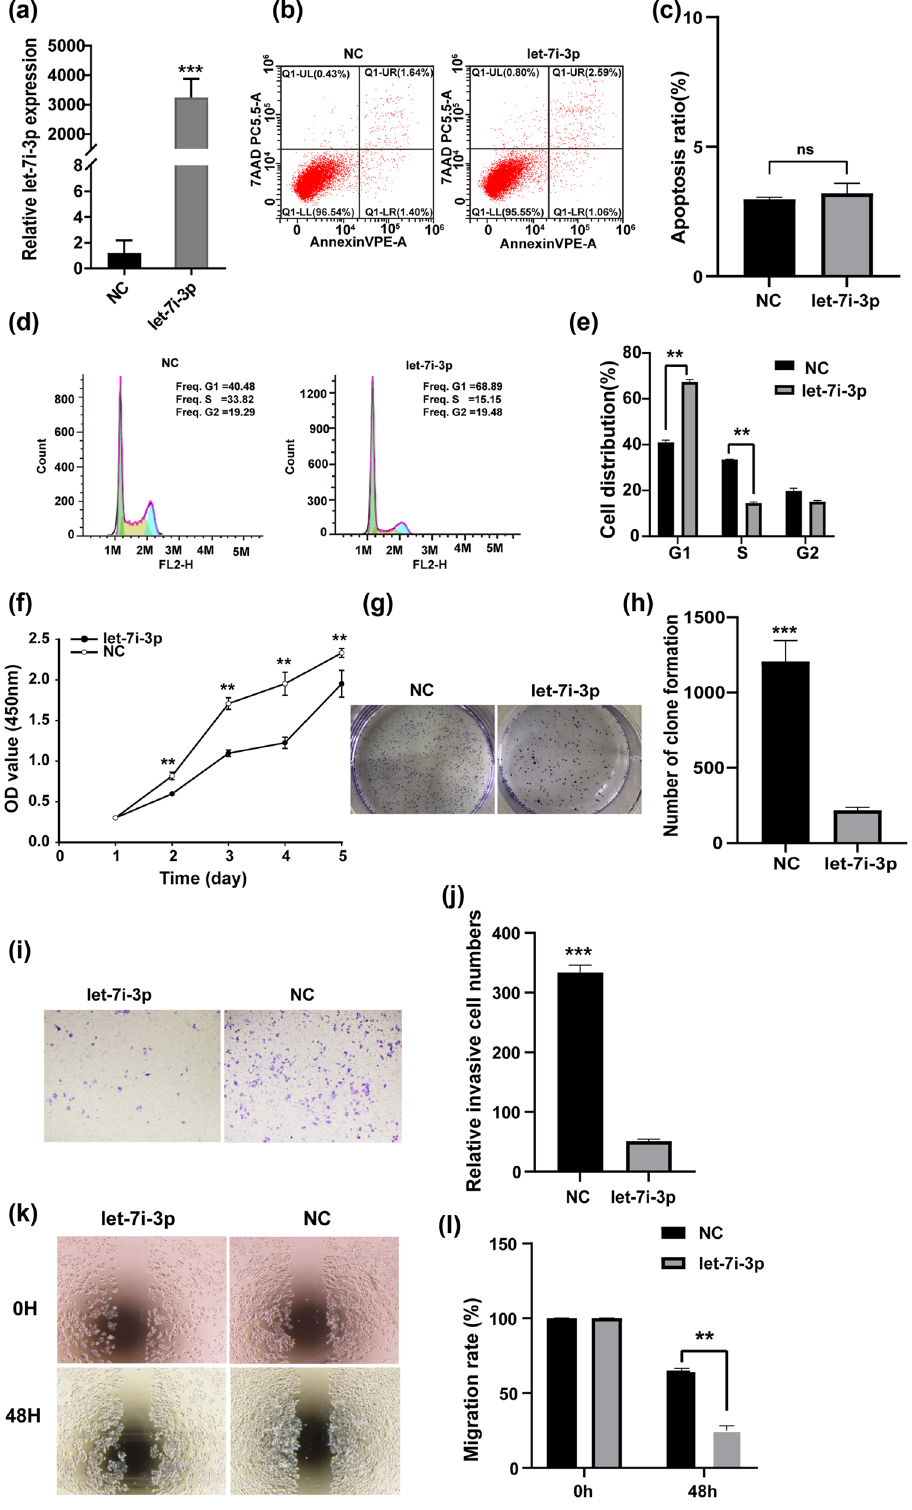
Figure 2: Let - 7i - 3p inhibits the cell cycle, proliferation, migration, and invasion but does not a ff ect the apoptosis in HCT116. ( a ) The expressions of let - 7i - 3p were measured after transfecting let - 7i - 3p or NC into HCT116 cells. ( b and c ) Cell viability was determined by Annexin - V/7 - AAD staining. Representative fl ow cytometric analysis of apoptosis ( b ) and statistical histogram was shown at right ( c ) . ( d ) Relative cell cycle distribution detected by fl ow cytometry and statistical histogram was shown at right ( e ) . ( f ) The e ff ects of let - 7i - 3p mimics or NC on HCT116 cells ’ proliferation as determined by CCK - 8 assay. ( g ) A colony formation assay was used to detect the cell colony formation ability after the transfection of let - 7i - 3p in HCT116 cells and a statistical histogram was shown at right ( h ) . ( i ) The e ff ects of let - 7i - 3p mimics and NC on HCT116 cells ’ invasion determined by transwell assay and statistical histogram was shown at right ( j ) . ( k ) Images were acquired at 0 and 48 h after wounding. The percentage of the wound healing was calculated as ( the width of wound at 0 h − the width of wound at 48 h ) /the width of wound at 0 h and a statistical histogram was shown at right ( l ) . * P < 0.05, ** P < 0.01, and *** P <